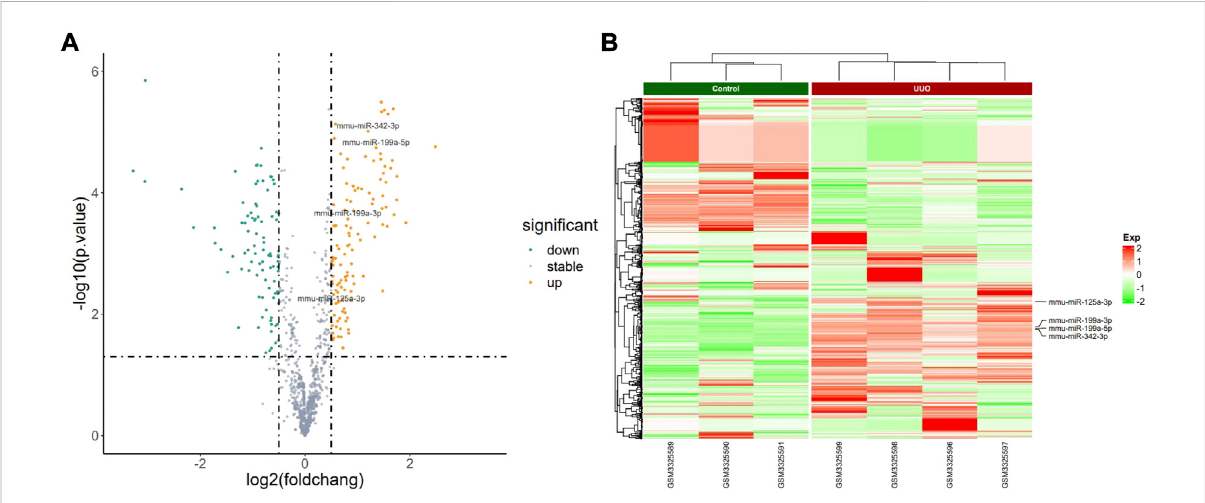
FIGURE 2 Pro fi ling of DEmiRNAs in the UUO group and control group in GSE118340. (A) Volcano plots. Orange represents upregulation and green represents downregulation. (B) Heatmaps. Red represents upregulation and green represents downregulation.